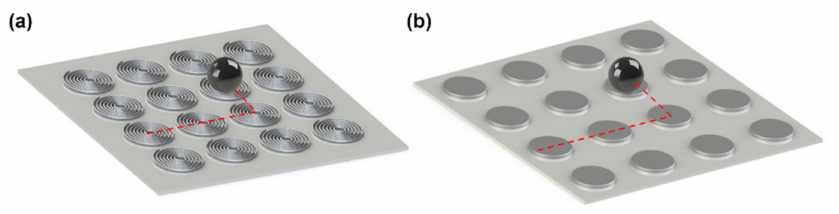
Figure 9. Schematics of magnetic single-particle transport using an array of ( a ) coils and ( b ) magnetic thin disks. The red dashed lines show the movement of the particle (black circle) from one coil/disk to the other